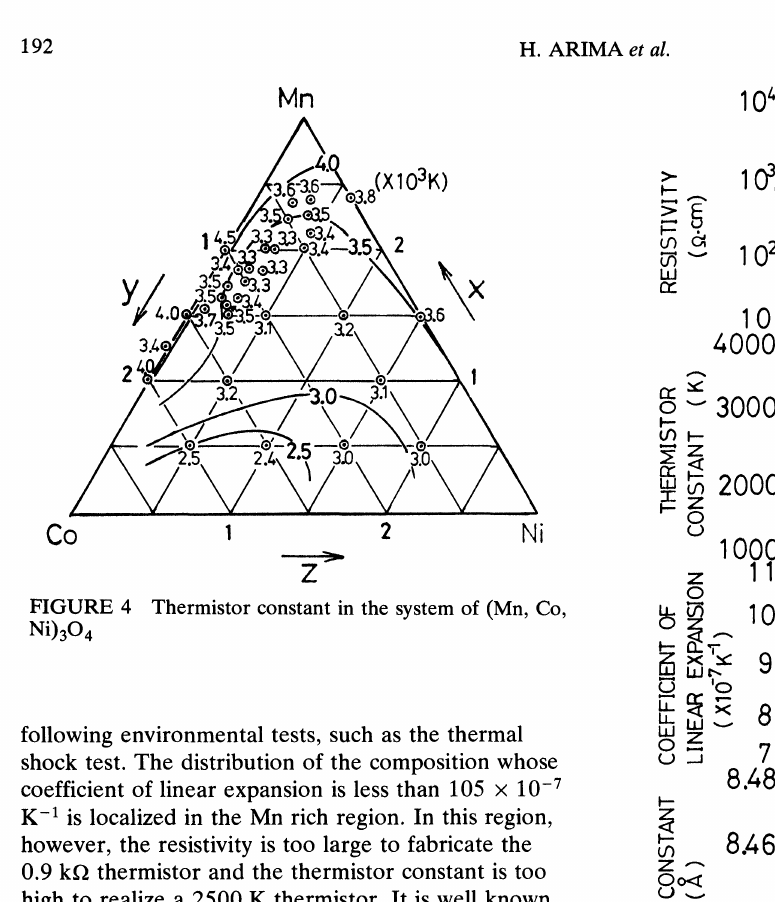
FIGURE 5 Characteristics of the system (1 x/3)Mn2Co0.Ni0.O